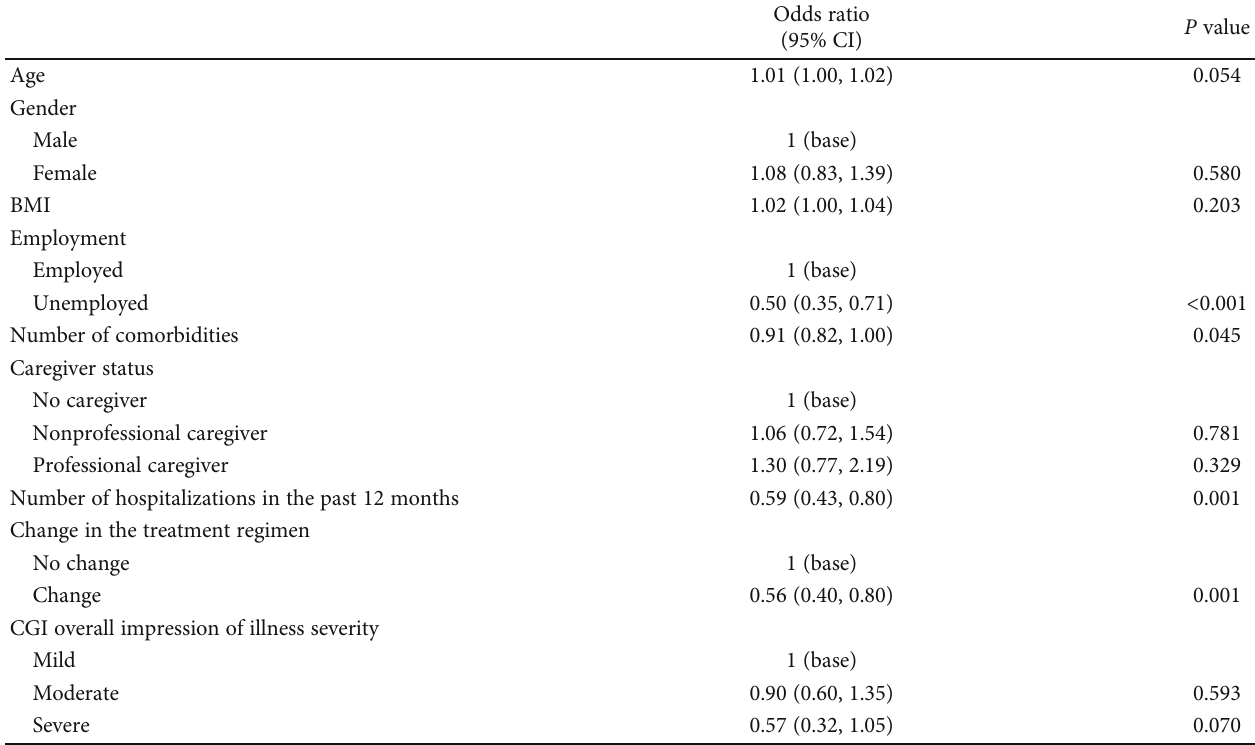
Table 3: Drivers of patient